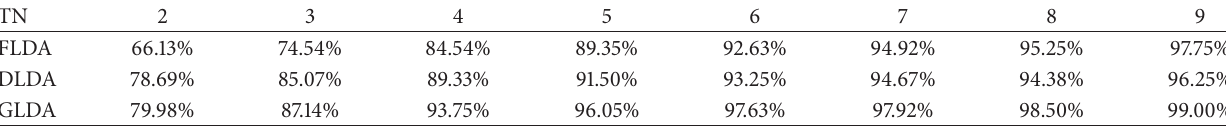
Table 1: Recognition rates on ORL database.